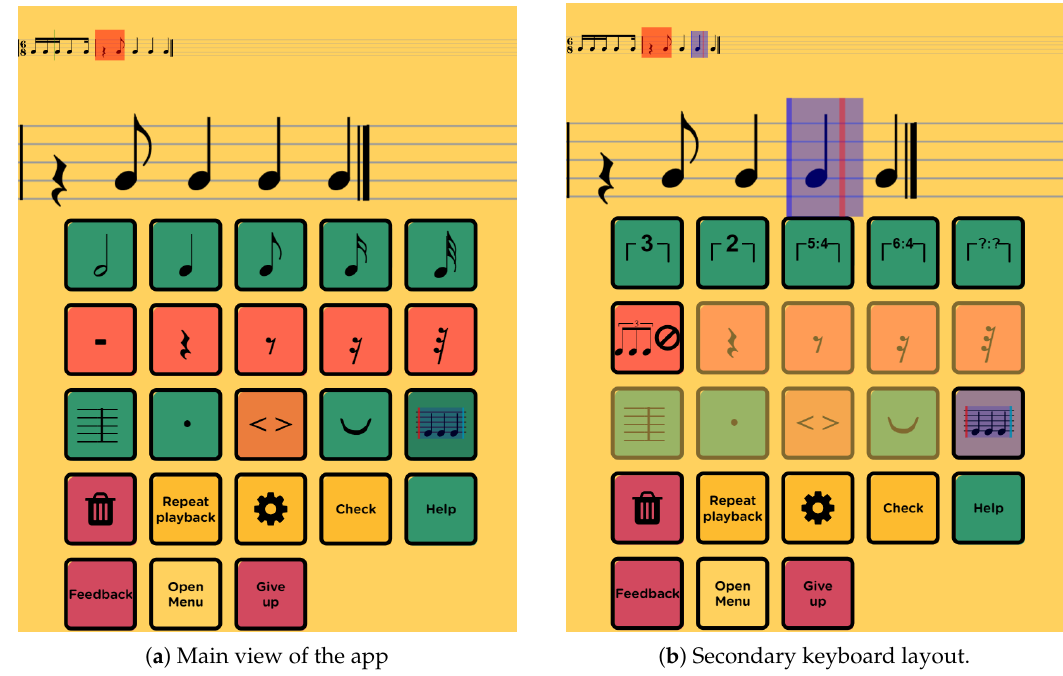
Figure 1. The main screen of the rhythmic dictation application on a mobile device ( left ). The primary rhythm input interface is shown below the staves. The secondary keyboard layout with options for adding and modifying subdivisions is shown on the ( right ).